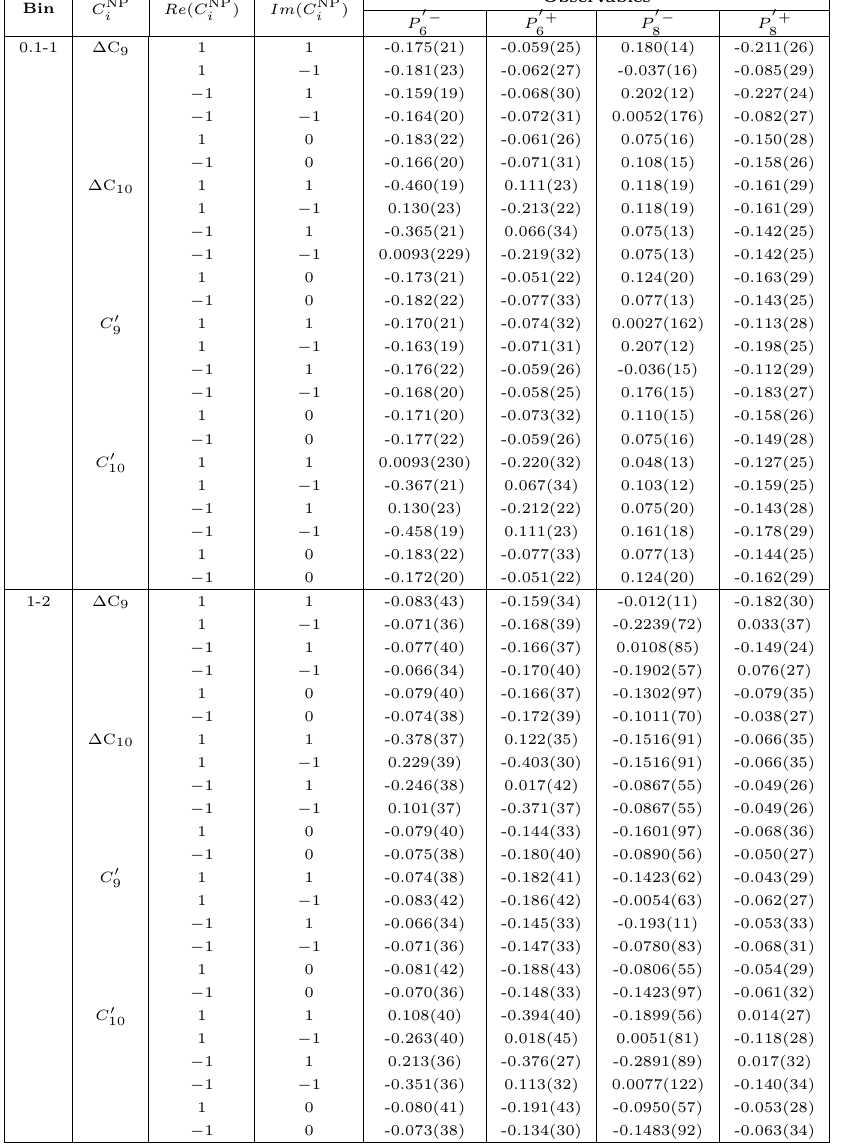
for the q 2 bins 0 . 1 − 1 9 , 10